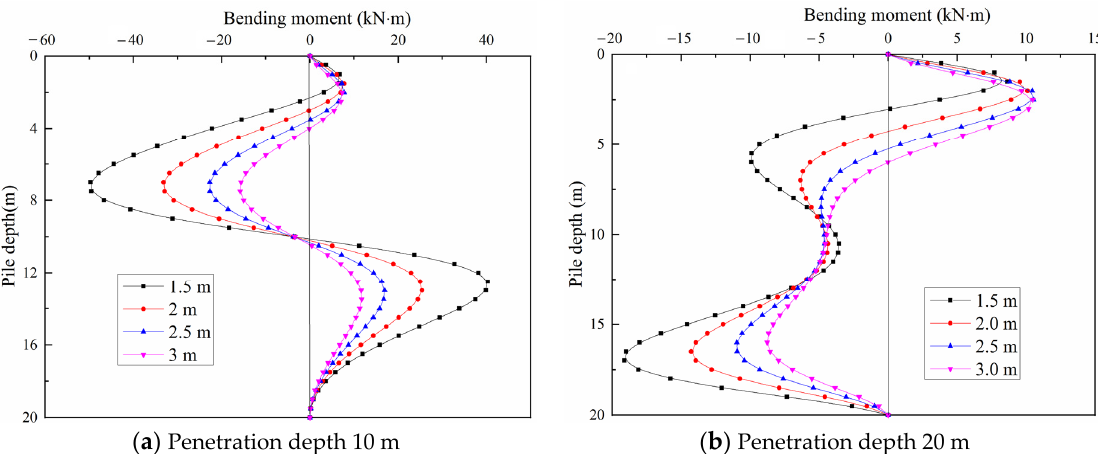
Figure 15. Influence of the distance between the used and new piles on bending moment of used pile.